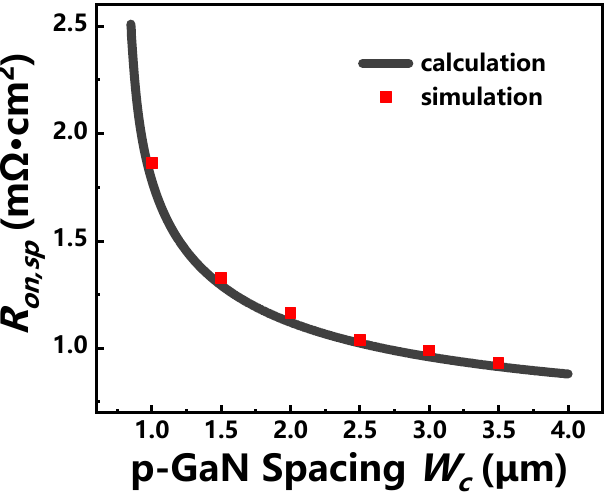
Figure 10. Comparison of the specific on-resistance calculated from the resistance analysis model with the simulation results for TJBS diodes with θ = 60°.